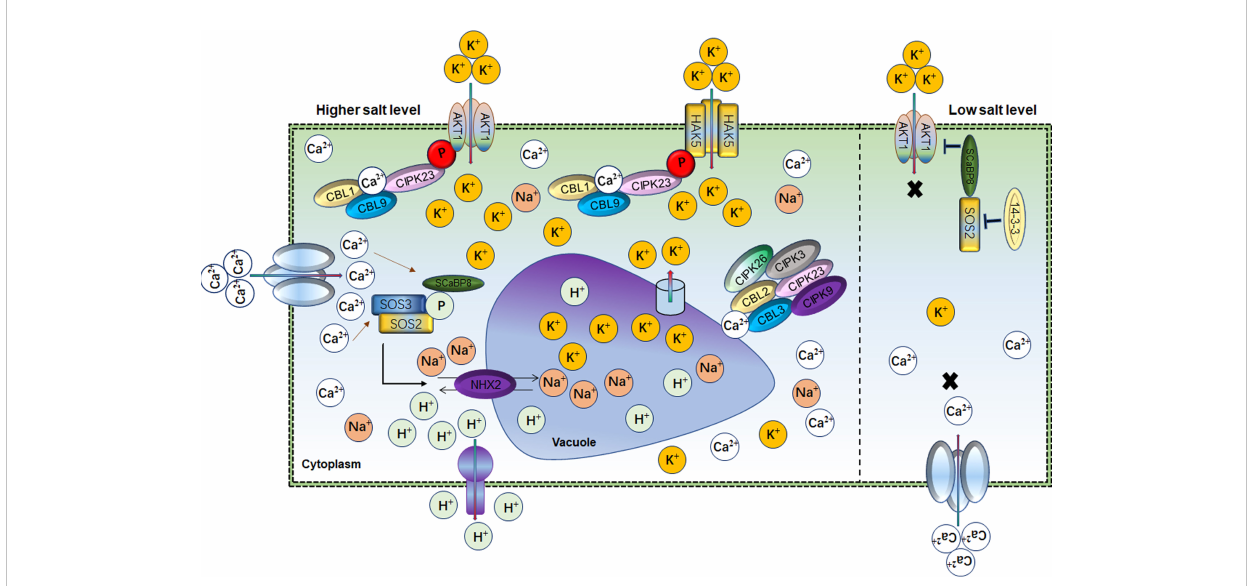
FIGURE 3 Role of Ca 2+ and AKT1 channels in balancing the Na + /K + homeostasis Cellular ionic homeostasis under lower and higher salt conditions mediated by Ca 2+ and AKT1 channels. 14-3-3-SOS2- SCaBP8 module blocked AKT1 activity under low salt levels thus inhibiting the K + import into the cell. However, under salt stress, Ca 2+ activates SOS2 for SCaBP8 phosphorylation to separate from AKT1. SOS2 also had a key role in Na + /H + vacuolar partitioning. At the same time, the CBL – CIPK cascade activated across the differential gradients of K + , which mediate Ca 2+ in fl ux through AKT1 and HAK5 to increase cellular K + . In parallel, vacuolar K + remobilized through the interaction of CBL2/3 with four CIPKs through K + channels to maintain the K + /Na +